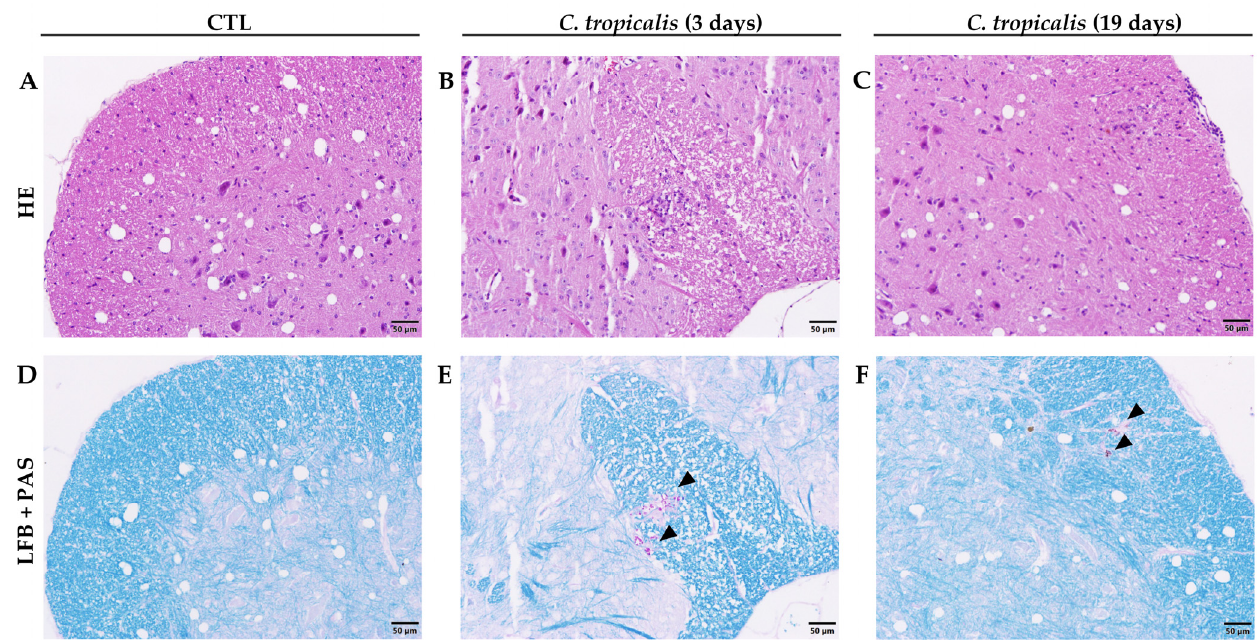
Figure 2. Dissemination of C. tropicalis to the spinal cord of C57BL/6 mice. Female C57BL/6 mice were infected with 1 × 10 6 viable C. tropicalis yeasts and evaluated for inflammatory infiltrate ( A – C ) and presence of yeasts ( D–F ), indicated by arrows, in the lumbar spinal cord. Representative images of each group.